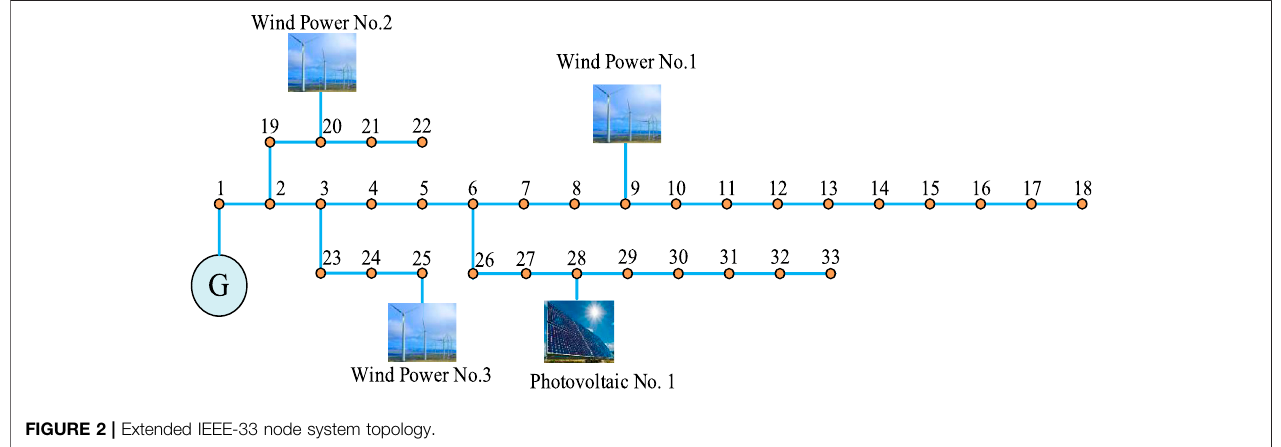
FIGURE 2 | Extended IEEE-33 node system topology.